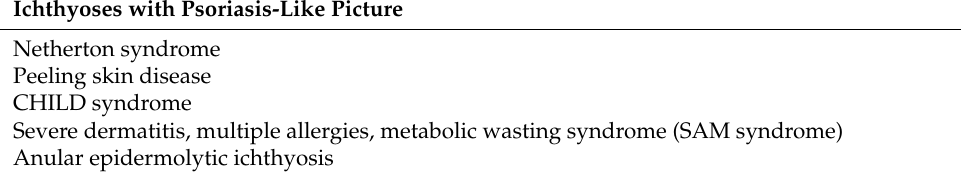
Table 2. Ichthyoses with a psoriasis-like